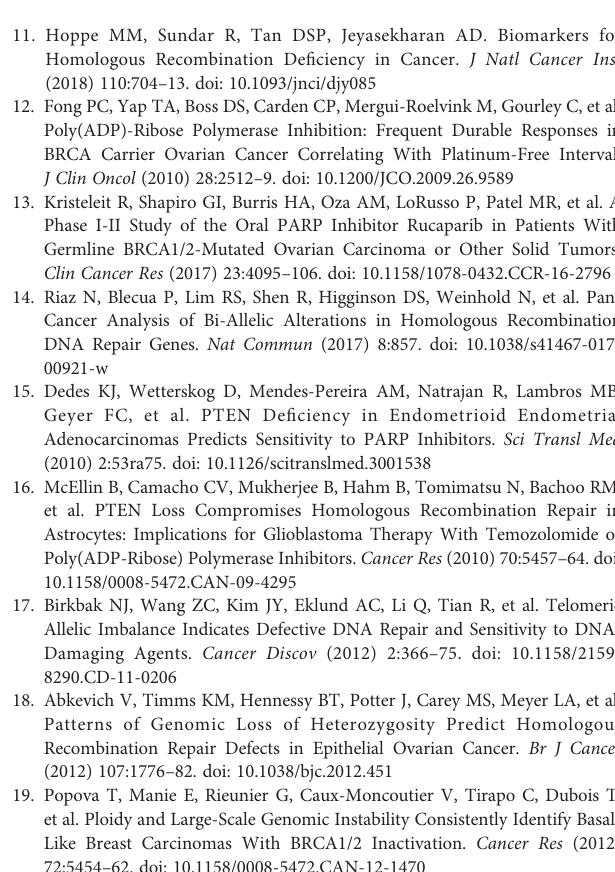
Supplementary Figure 1 | Flow chart of the study design. Supplementary Figure 2 | Histograms, quantile-quantile plots, and normality tests for the data. Supplementary Table 1 | Summary of dataset size. Supplementary Table 2 | Clinical characteristics of patients per HRD status from the TCGA-OV cohort. Supplementary Table 3 | HRD score of TCGA patients. Supplementary Table 4 | HRD status in AOCS cohort. Supplementary Table 5 | Summary of clinical characteristics of TCGA pan- cancer cohort. Supplementary Table 6 | Summary of cancer types and HRD score in TCGA pan-cancer